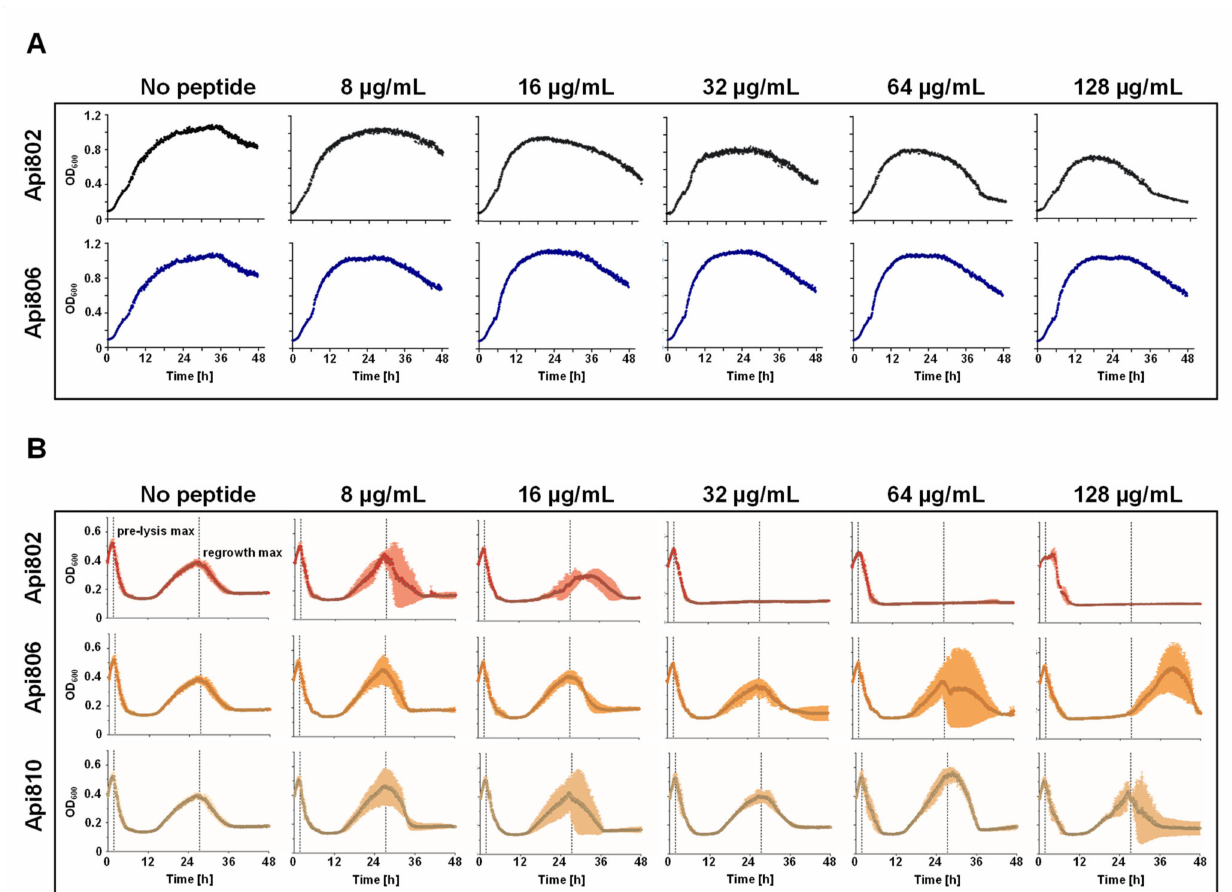
Figure 2. ( A ) Influence of apidaecin analogs Api802 (black) and Api806 (blue) added in increasing concentrations to an E. coli Rosetta pLysS culture in LB medium and incubated at 37 ◦ C; ( B ) Influence of the studied apidaecin analogs on phage-mediated lysis including the appearance of potentially phage-resistant bacteria. Api802 (red), Api806 (orange), and Api810 (beige) were added in increasing concentrations to an E. coli Rosetta pLysS culture in LB medium, inoculated with T7Select phage (MOI 0.0625), and incubated at 37 ◦ C. The OD 600 was recorded every 5 min for 48 h. Dashed lines indicate the maximal OD 600 values before lysis (pre-lysis max) and the highest OD 600 values of the regrowth phase (regrowth max) of a control experiment without addition of a peptide. Experiments were completed twice in triplicates. Error bars show the standard deviation of all three replicates of one representative